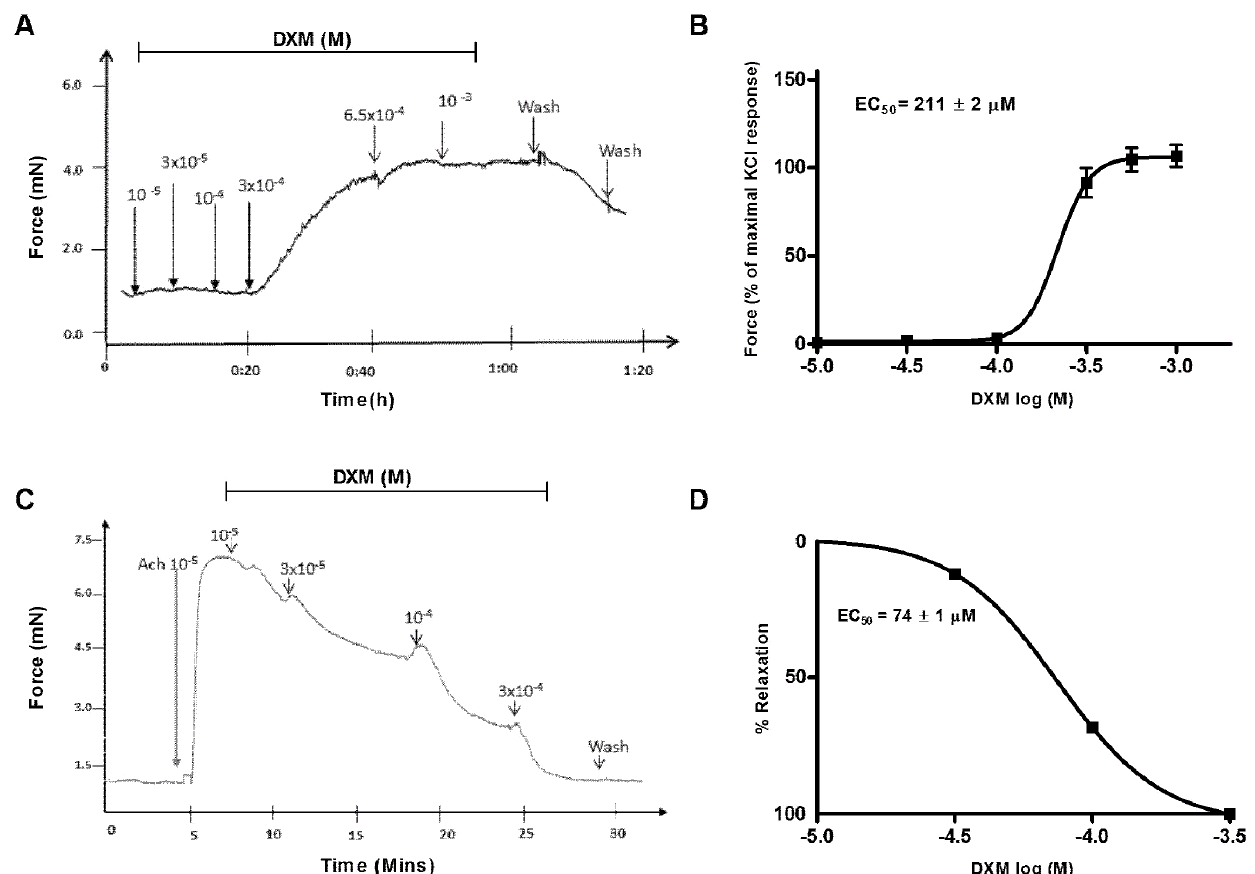
Figure 5. Myograph analysis of the effects of DXM on the porcine pulmonary arterial and airway rings. A. The figure represents the raw trace showing the effect of DXM (10 2 5 to 10 2 3 M) stimulation on resting tension of pulmonary artery rings. Force generation started from 300 m M, increasing slowly to plateau after 15–20 min; followed by a slight increase in force at 650 m M DXM. There was no further increase in tension even with up to 1 mM DXM. Force returned to baseline 20–30 min after 3–4 washings of pulmonary artery rings with Krebs solution. B . Dose response curve of DXM normalized to maximal KCl stimulation in pulmonary arterial rings. Cumulative dose response curve of DXM with highest concentration being 3 6 10 2 4 M and lowest 10 2 5 M on isometric tension of pulmonary artery rings. The DXM responses were normalized to maximal KCl stimulation and the EC 50 was calculated to be 211 6 2 m M. The results are presented as mean 6 SEM and are from a minimum of n=15 rings from 5 piglets. C . Representation of raw trace of the DXM doses added to piglet airway rings precontracted with 10 2 5 M ACh. DXM completely relaxed the precontracted airways in a dose dependent manner reaching baseline at 3 6 10 2 4 M. D . Dose response curve of DXM normalized to maximal KCl stimulation in airway rings. The figure shows the effect of DXM dose response on porcine airway rings precontracted with 10 2 5 M ACh. DXM- mediated relaxation is expressed as percentage of the maximum force due to KCl stimulation and the EC 50 calculated was found to be 74 6 1 m M. The results are presented as mean 6 SEM and are from a minimum of n=15 rings from 5